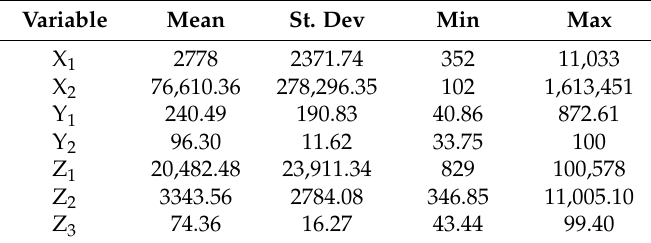
Table 3. Descriptive summaries of inputs and outputs in 2016.